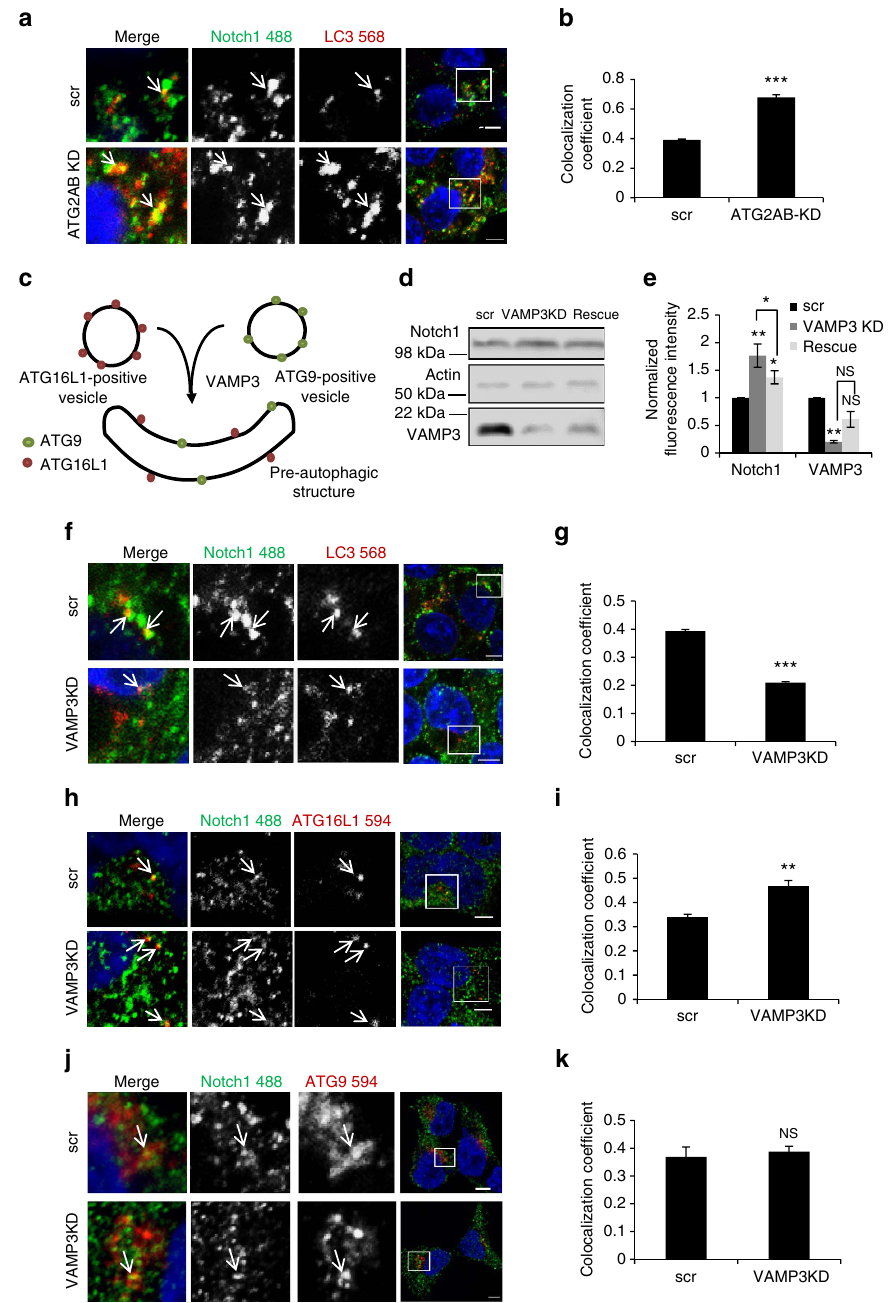
Figure 4 | Notch1 can enter the autophagosomes in precursor structures. ( a ) Effect of inhibition of autophagy pathway components downstream (ATG2A and ATG2B) of LC3 on the colocalization of Notch1 with LC3. HEK cells were transfected with scrambled siRNA (scr) or ATG2AB siRNA. The arrows show LC3 and Notch1 colocalization. Scale bar, 5 m m. ( b ) Measurement of colocalization coefficient between Notch1 and LC3 in scrambled control and ATG2A/B knockdown conditions using Volocity software. *** P o 0.001 by unpaired t- test relative to scrambled siRNA (scr) transfection. n ¼ 3. Error bars ¼ s.e.m. ( c ) Schematic of VAMP3-mediated fusion of ATG16L1 and ATG9 vesicles forming ATG16L1- and ATG9-double-positive pre-autophagosomal structures. ( d ) Representative western: Protein levels of Notch1 and VAMP3 were assessed by western blot with actin loading control after VAMP3 knockdown ± VAMP3 cDNA rescue. ( e ) Quantification of western blots for Notch1 and VAMP3, relative to actin and normalized for the relevant control. * P o 0.05 or * P o 0.01 by paired t- test. NS denotes not significant. n ¼ 4. Error bars ¼ s.e.m. ( f ) HEK cells were transfected with scrambled siRNA (scr) or VAMP3 siRNA. Arrows show LC3 and Notch1 colocalization. Scale bar, 5 m m ( g ) Colocalization coefficient between Notch1 and LC3 shown in f using Volocity software. *** P o 0.001 by unpaired t- test relative to scrambled siRNA (scr) transfection. n ¼ 3. Error bars ¼ s.e.m. ( h ) HEK cells were transfected with scrambled siRNA (scr) or VAMP3 siRNA. Arrows show ATG16L1 and Notch1 colocalization. Scale bar ¼ 5 m m. ( i ) Colocalization coefficient between Notch1 and ATG16L1 shown in h using Volocity software. ** P o 0.01 by unpaired t -test relative to scrambled siRNA (scr) transfection. n ¼ 3. Error bars ¼ s.e.m. ( j ) HEK cells were transfected with scrambled siRNA (scr) or VAMP3 siRNA. Arrows show ATG9 and Notch1 colocalization. Scale bar, 5 m m. ( k ) Colocalization coefficient between Notch1 and ATG9 shown in j using Volocity software. NS denotes not significant by unpaired t -test relative to scrambled siRNA (scr) transfection. n ¼ 3. Error bars ¼ s.e.m.